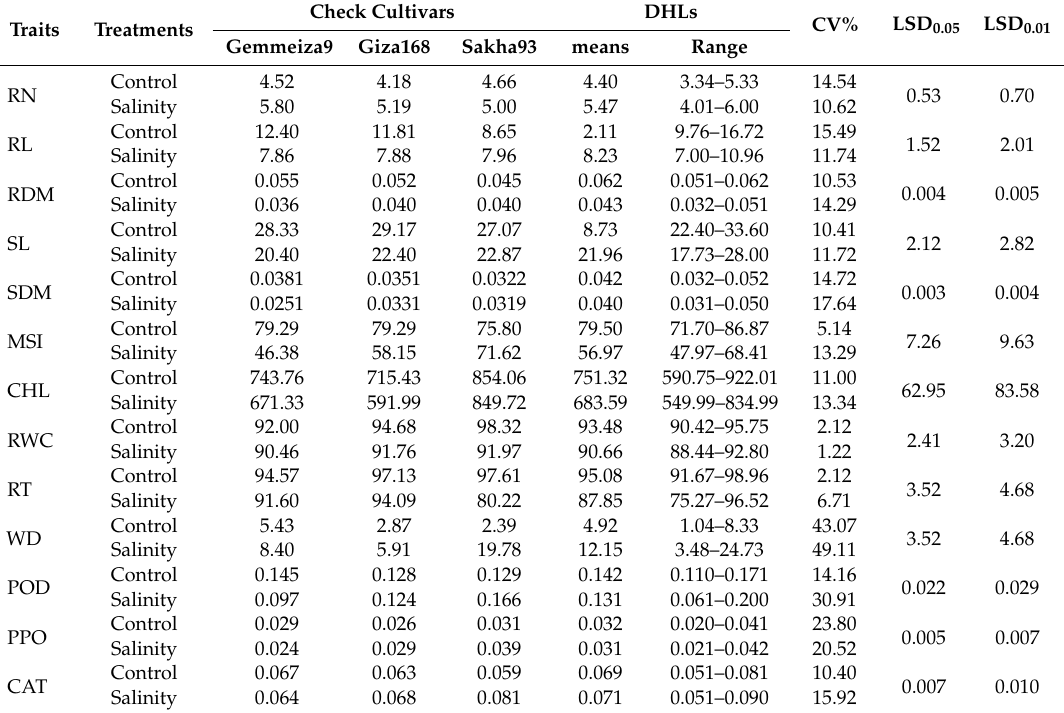
Table 1. Mean values, range of mean, coe ffi cient of variation (CV), and LSD for the 13 measured traits of wheat genotypes grown in control and salinity